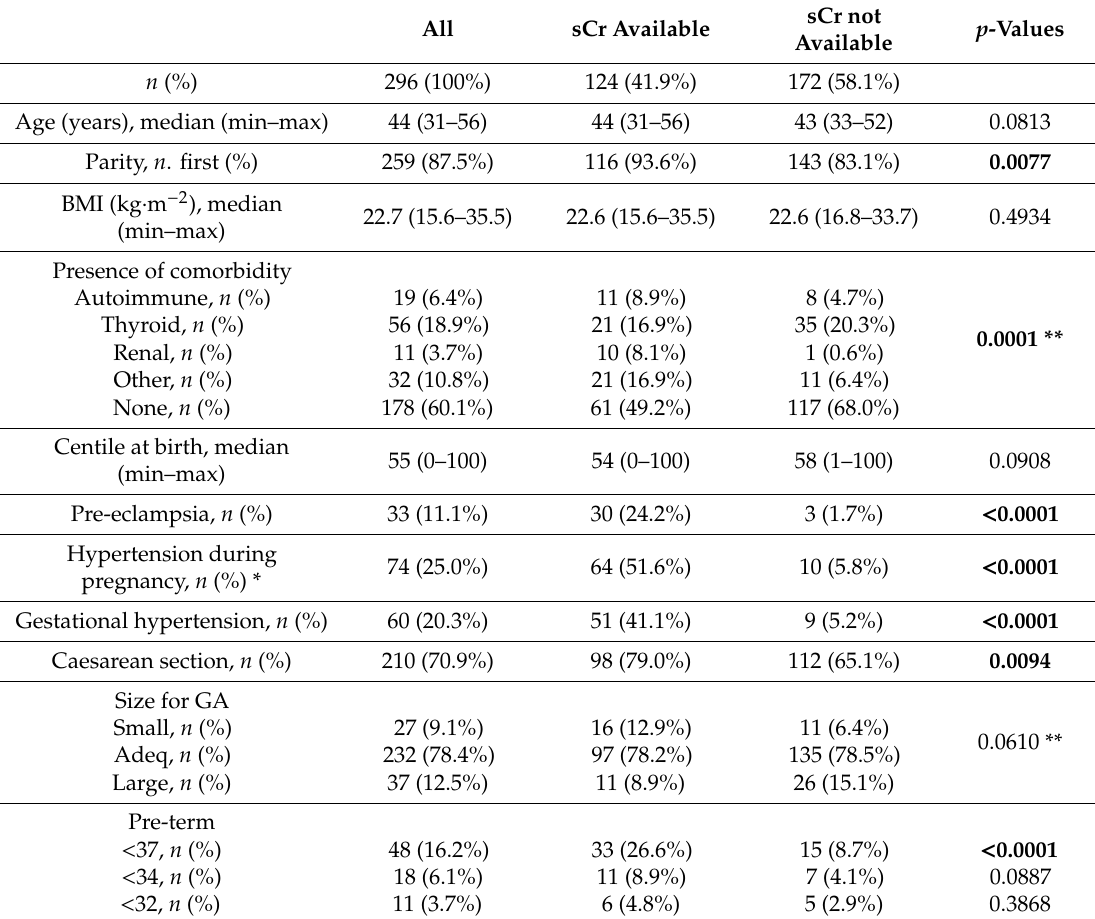
Table 3. Comparison of subsets of egg donation pregnancies with or without an available creatinine test. sCr not All sCr Available